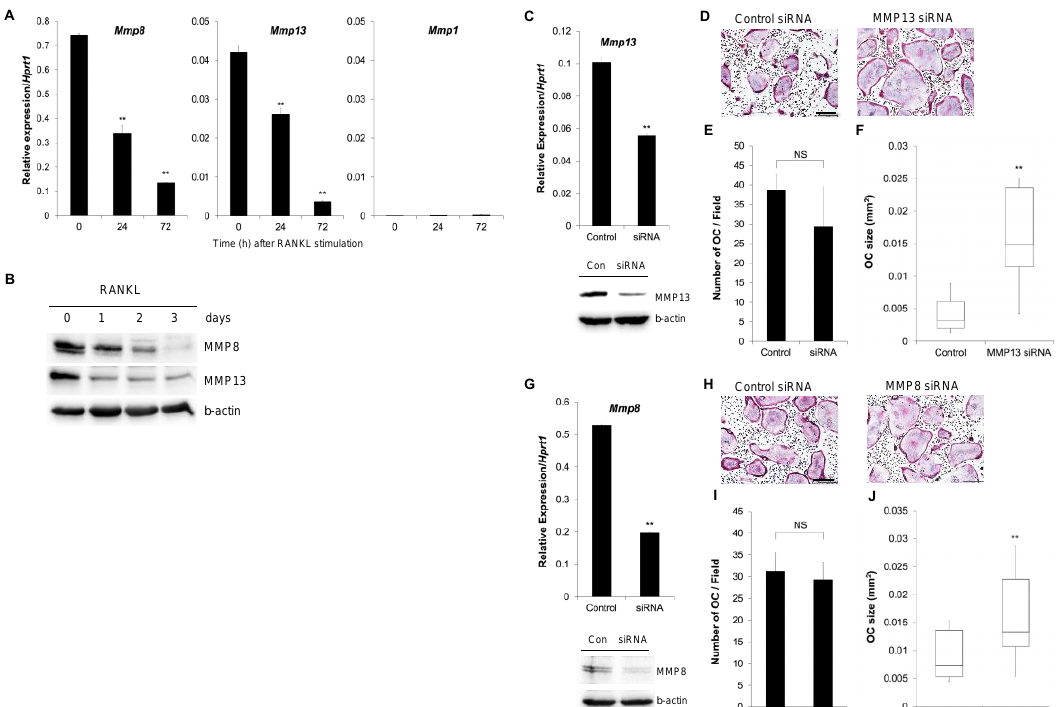
Figure 1. The role of matrix metalloprotease (MMP)8 and MMP13 on osteoclast differentiation. ( A ) Bone marrow macrophages (BMMs) were cultured in the presence of macrophage-colony stimulating factor (M-CSF) and receptor activator of nuclear factor κB ligand (RANKL) for 3 days, and the expression of collagenases was determined by real-time RT-PCR analysis. ( B ) BMMs were cultured as in ( A ) were lysed and subjected to Western blot analyses. ( C ) BMMs were cultured in the presence of MMP13-siRNA for 2 days and the expression of MMP13 was confirmed by real-time RT-PCR analysis (upper panel) and Western blot (lower panel). ( D ) Cells in ( C ) were further cultured in the presence of M-CSF and RANKL for 5 days and stained for tartrate-resistant acid phosphatase (TRAP) activities. ( E ) The number of TRAP-positive osteoclasts with more than 3 nuclei was counted from experiments in ( D ). ( F ) The size of osteoclasts was measured from the experiments in ( D ). ( G ) The MMP8 mRNA and protein expression were examined after culturing BMMs with MMP8-siRNA for 2 days. ( H ) Cells in ( G ) were further cultured in the presence of M-CSF and RANKL for 5 days and stained for TRAP activities. ( I ) The number of osteoclasts was counted from experiments in ( H ). ( J ) The osteoclast size from the experiments in ( H ) was measured. Data are mean ± SD of triplicate experiments representative of three independent experiments. **, p < 0.01 versus control. Scale bars indicate 100 µ